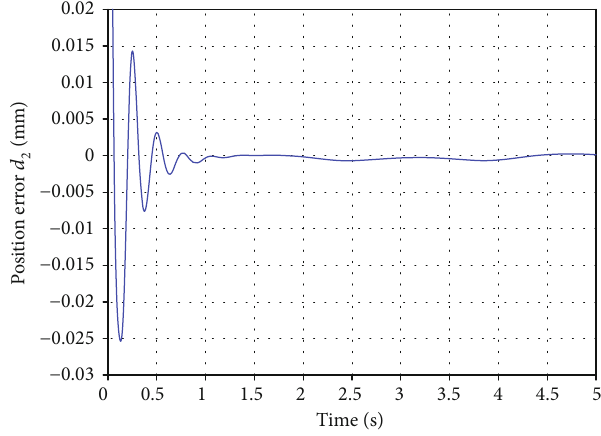
Figure 7: The position error of the second actuated joint d . 1